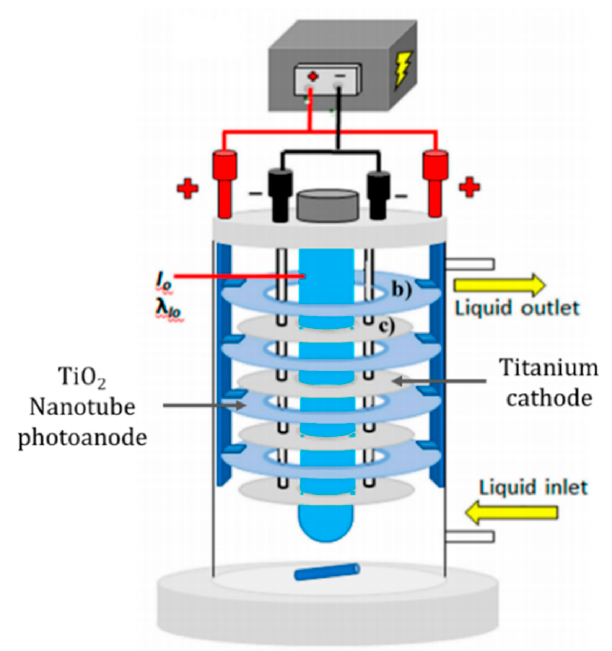
Figure 11. Schematic representation of the experimental set-up using anodised titanium photoanode. (Adapted with permission from [63]: Montenegro-Ayo, R.; Morales-Gomero, J.C.; Alarcon, H.; Cotillas, S.; Westerhoff, P.; Garcia-Segura, S. Scaling up Photoelectrocatalytic Reactors: A TiO 2 Nanotube-Coated Disc Compound Reactor Effectively Degrades Acetaminophen. Water 2019 , 11 , 2522, doi:10.3390/w11122522. Copyright (2019), MDPI (Basel, Switzerland)).